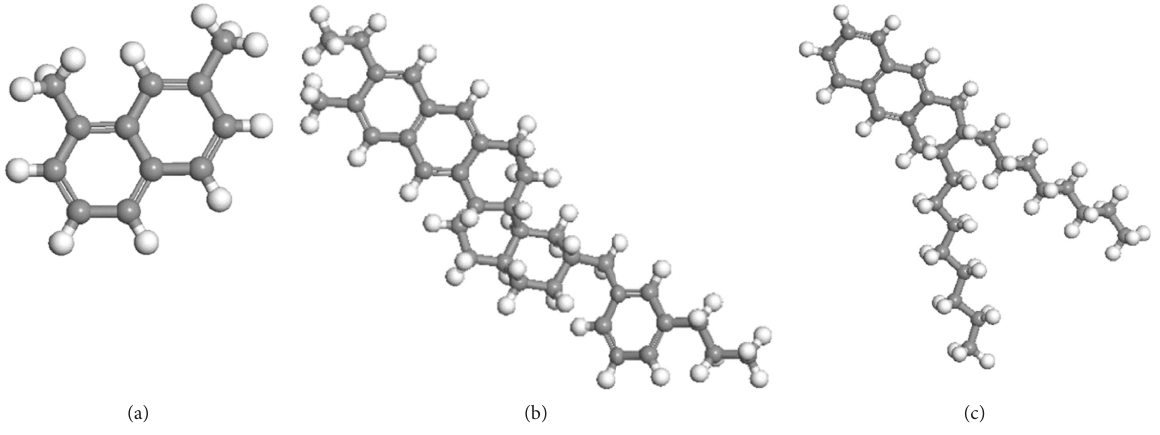
Figure 5: Typical molecular structures for naphthene aromatics [37, 38].